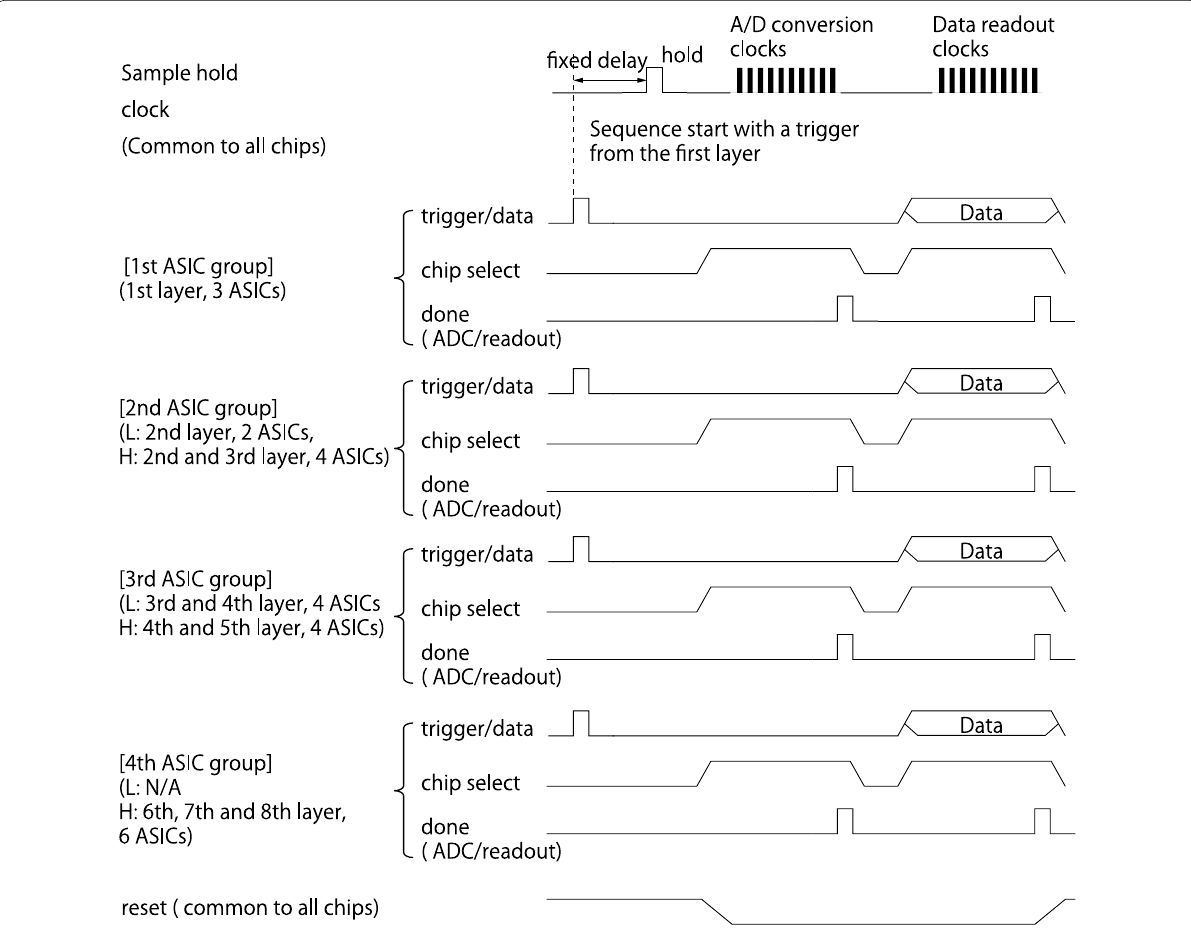
Fig. 7 Timing chart for signal processing with VATA460.3. Readout sequence begins with trigger signal from ASICs in first SSD layer. The CONTROL board inputs a sample/hold signal to all ASICs after a defined delay from the trigger signal. The CONTROL board supplies the ADC clocks and receives a signal from the ASICs when the conversion is finished. After receiving confirmation from all ASICs that the A/D conversion has completed, the CONTROL board supplies the ASICs readout clock. After reading out all the data, the CONTROL board resets the digital part of the ASICs and waits for the next trigger